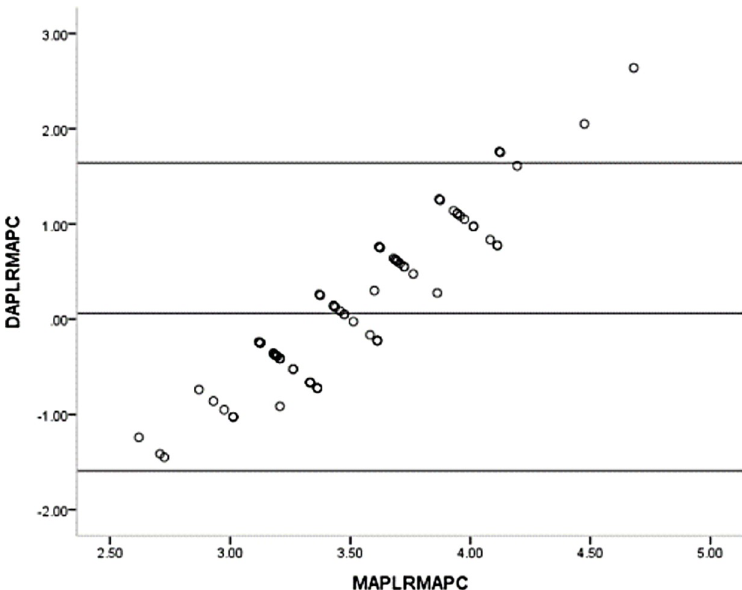
Fig 7. Bland-Altman plot of AP and the RM after pupillary contraction. APL = advanced penlight; RM = refractometer; DAPLRMBPC = difference of advanced penlight and refractometer after pupillary contraction; MAPLRMBPC = mean of advanced penlight and refractometer after pupillary contraction.